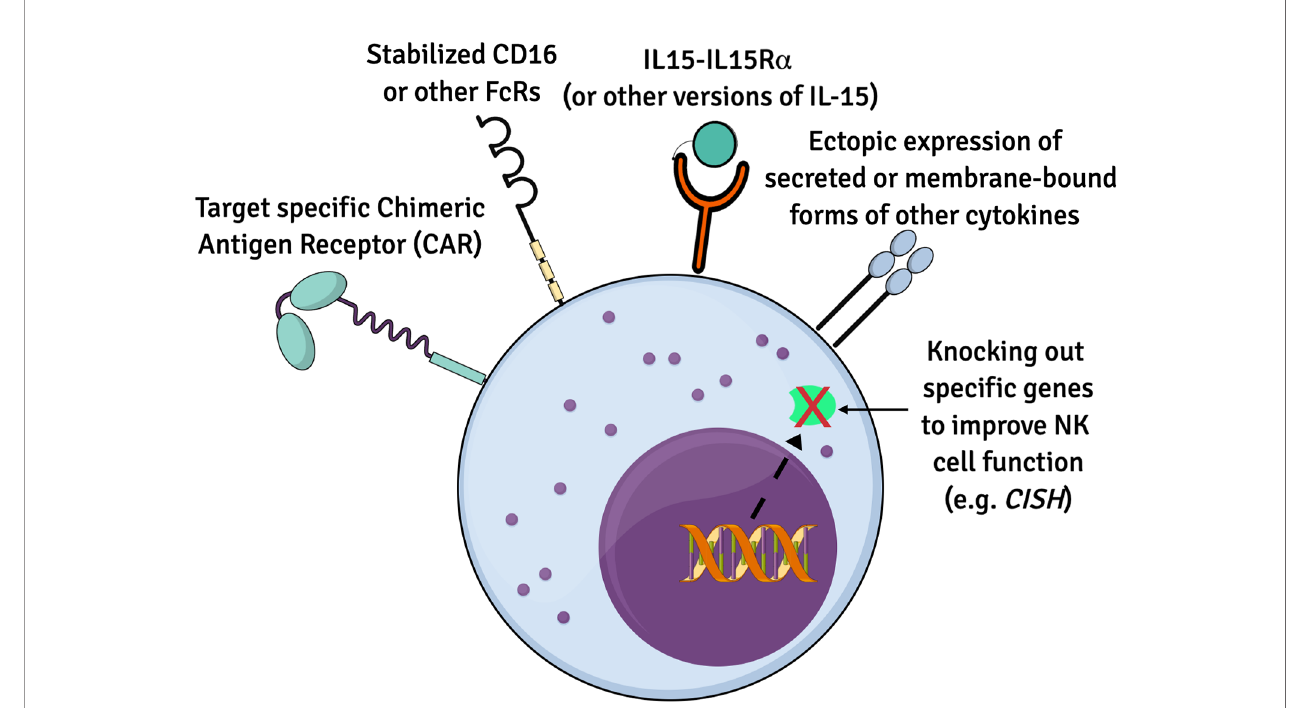
FIGURE 1 | Summary of genetic modi fi cations to improve iPSC-NK cells. Numerous genetic alternations have been engineered to enhance the biology and function of iPSC-derived NK cells for therapeutics. Ectopic expression of IL15 and/or other cytokines, CARs to boost anti-tumor cytotoxicity, recombinant CD16 and knockout of speci fi c genes such as CISH are some of the